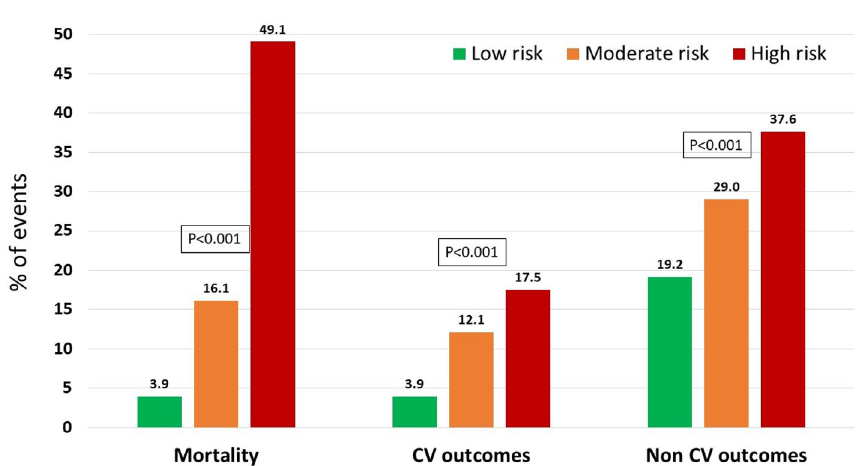
Figure 3. Outcomes by risk groups of COVID-19 lab score. CV cardiovascular (myocardial infarction, hospitalizations due to heart failure,